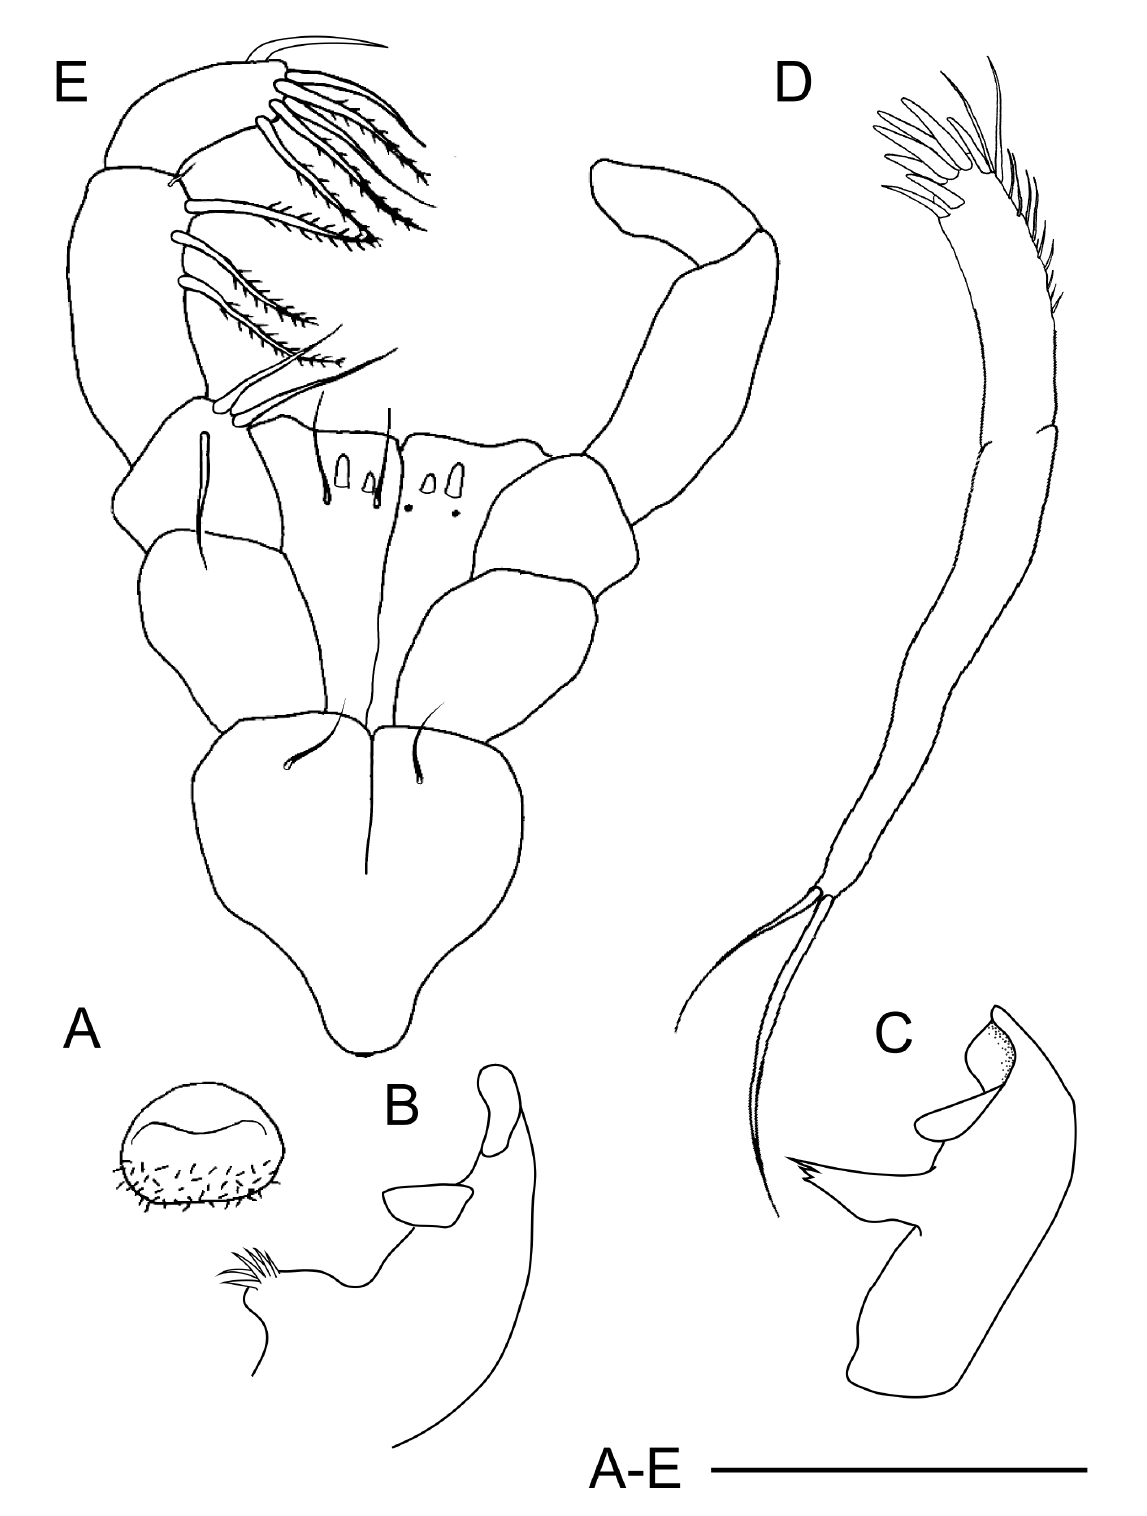
Fig. 7. Tirana vallis gen. et sp. nov. Paratype, adult, ♀ (DBUA0002211.02). A . Labrum. B–C . Left mandible. D . Maxillule. E . Maxilliped. Scale bar = 100